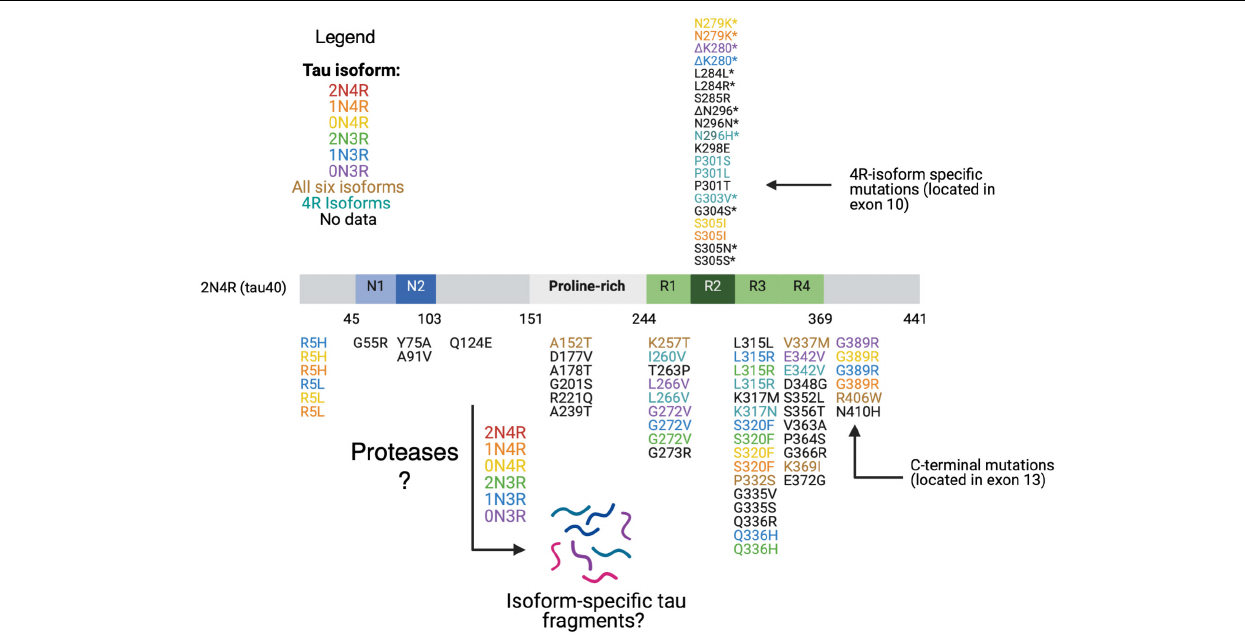
FIGURE 3 | Tau mutations. Tau mutations among parent tau isoforms are illustrated. MTBR tau missense and deletion mutations located in exon 10 and in exons 9,10, 11, and 12 are found in all six isoforms (R1, R2, and R3) and in only 4R isoforms (R2). The mutations are mapped against 441 aa 2N4R isoform. Reported mutations are can be found associated with familial FTDP-tau and other related tauopathy disorders based on evidence from the literature as follows: mutations are colored coded based on their presence in each of the six tau isoforms, in all six isoforms, in 4R isoforms, or no data on isoform(s) containing the mutation (Wolfe, 2009; Rossi and Tagliavini, 2015; Strang et al., 2019). Mutations with a * in exon 10 are associated with alterations in exon 10 splicing and relative isoform expression levels (Wolfe, 2009; Rossi and Tagliavini, 2015). Presently, the details of what tau fragments are generated from each wild-type or mutant tau isoform has yet to elucidated. It will be essential to assess whether 4R-isoform specific mutations generate different and/or similar fragments compared to normal 4R-isoforms, mutant 3R-isoforms, and normal